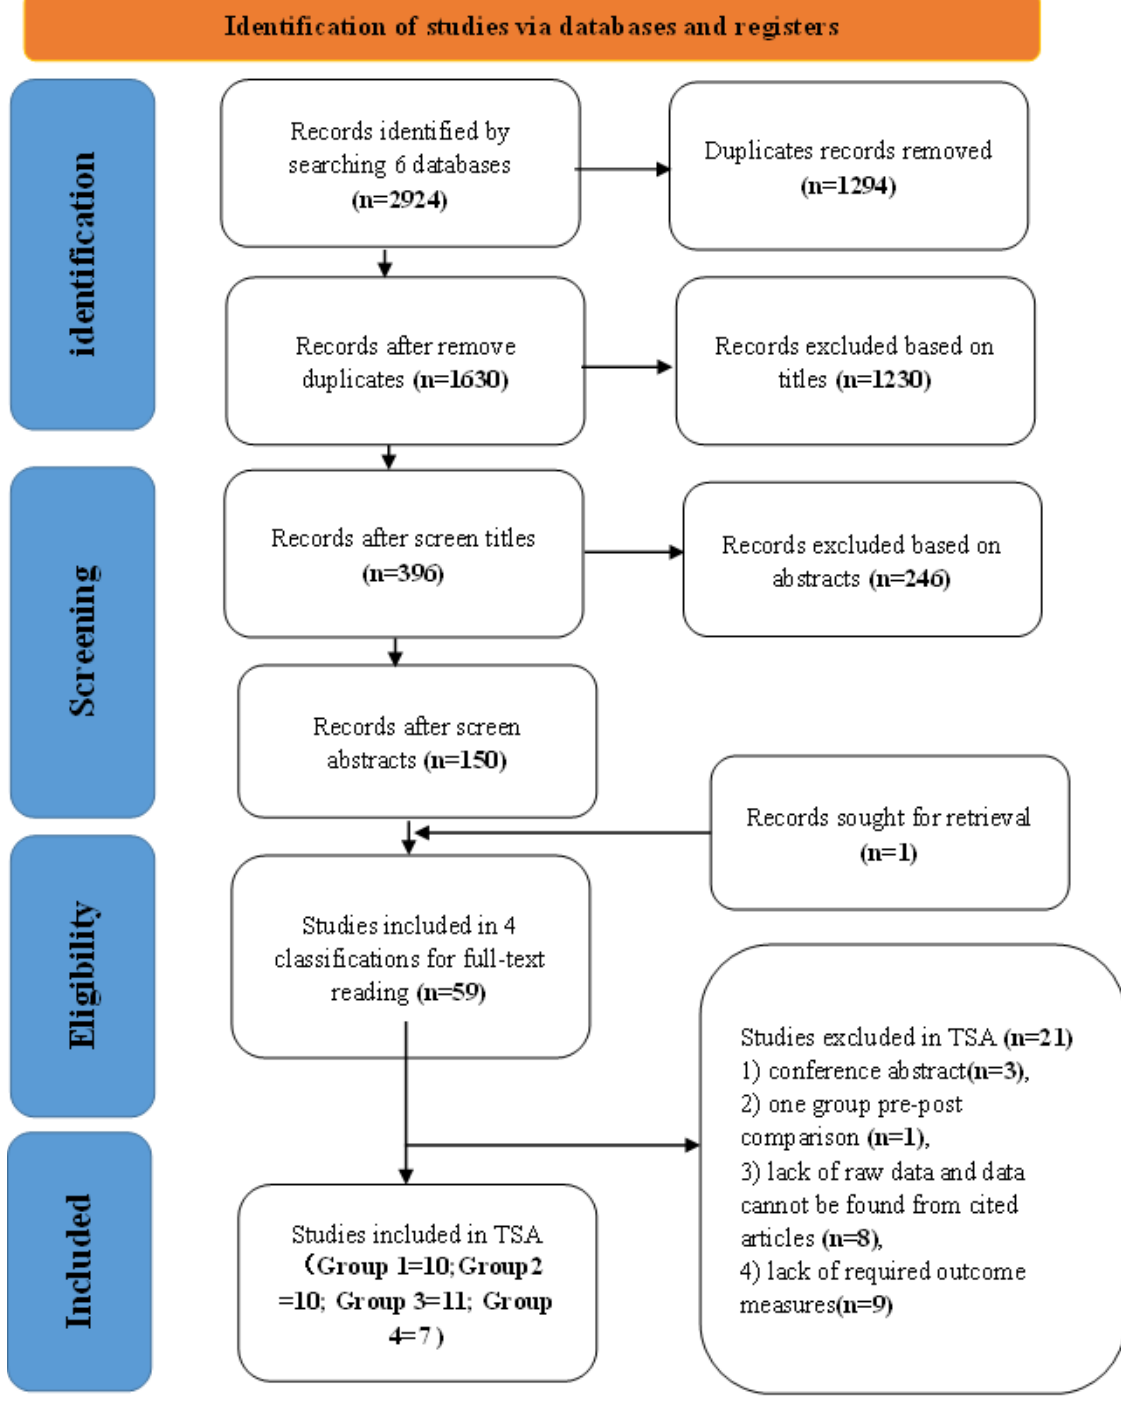
Figure 1. A flow diagram of the study Figure 1 A flow diagram of the study selection.